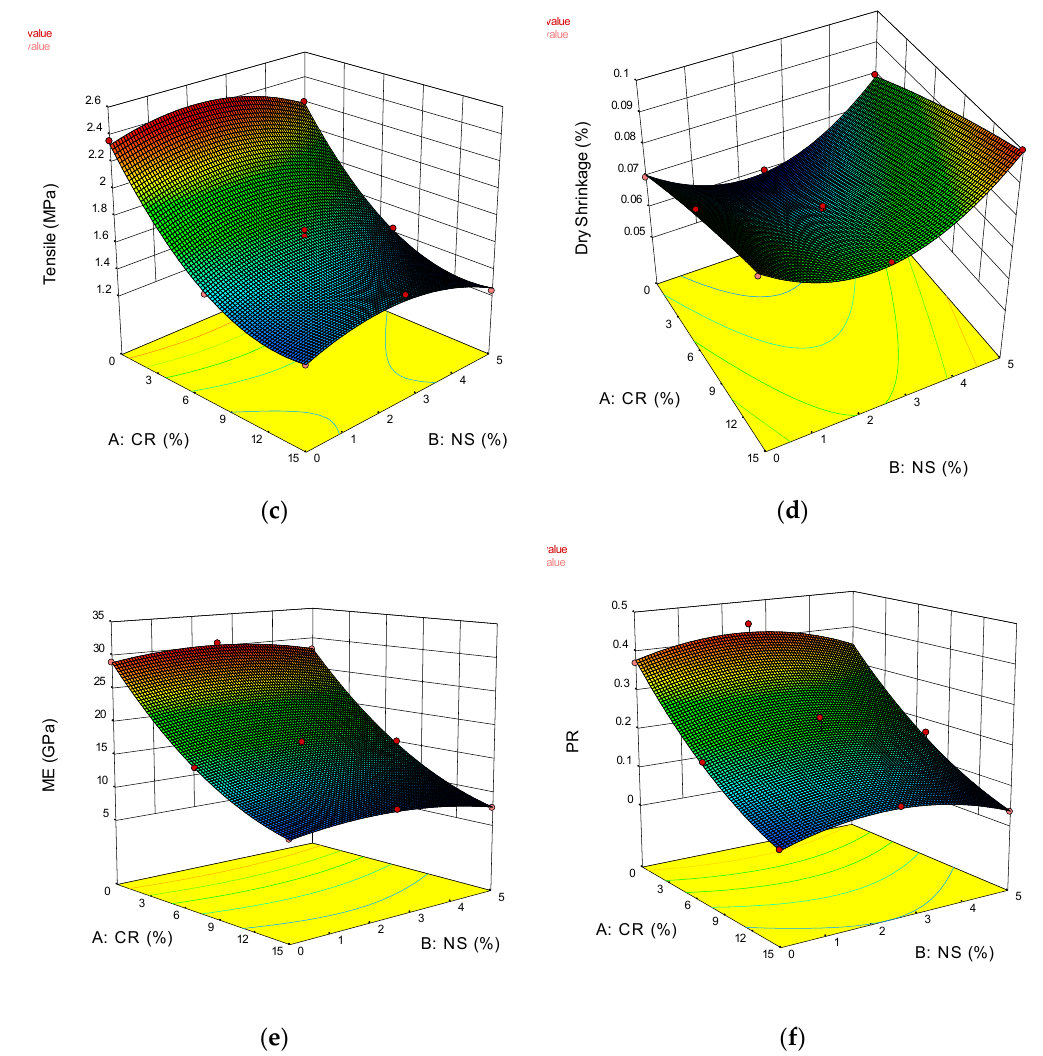
Figure 14. 3D contour plots for developed response models: ( a ) Compressive Strength; ( b ) Flexural Tensile Strength; ( c ) Direct Tensile Strength; ( d ) Drying Shrinkage; ( e ) Modulus of Elasticity; ( f ) Poisson’s Ratio.